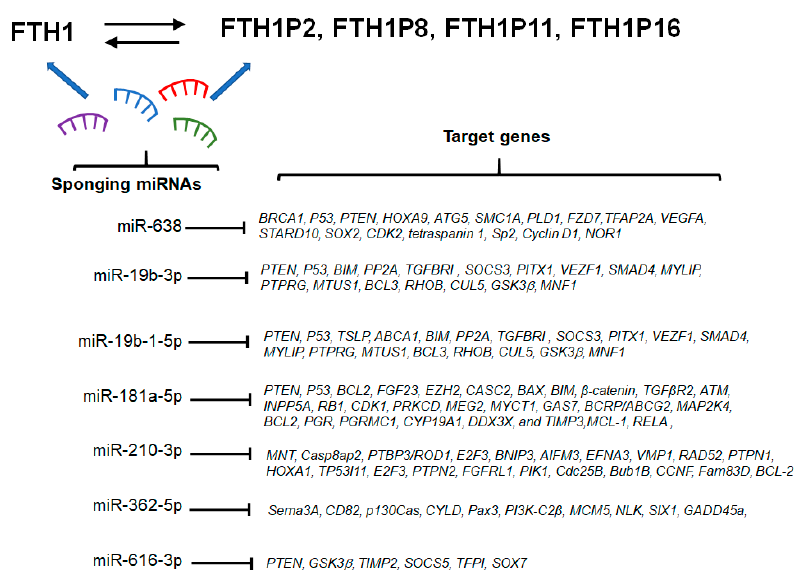
Figure 4. Potential networks involving FTH1 gene/pseudogenes and known oncogenes or tumor suppressor genes. Abbreviations used: BRCA1, BRCA1 DNA repair associated; P53, Tumor protein p53; PTEN, Phosphatase and tensin homolog; HOXA9, Homeobox A9; ATG5, Autophagy related 5; SMC1A, Structural maintenance of chromosomes 1A; PLD1, Phospholipase D1; FZD7, Frizzled class receptor 7; TFAP2A, Transcription factor AP-2 alpha; VEGFA, Vascular endothelial growth factor A; STARD10, StAR related lipid transfer domain containing 10; SOX2, SRY-box transcription factor 2; CDK2, Cyclin dependent kinase 2; TSPAN1, Tetraspanin 1; Sp2, Sp2 transcription factor; CCND1, Cyclin D1; NOR1, Neuron-derived orphan receptor 1; BIM, Bcl-2-like protein 11; PP2A, Protein phosphatase 2 phosphatase activator; TGFBR1, transforming growth factor beta receptor 1; SOCS3, Suppressor of cytokine signaling 3; PITX1, Paired like homeodomain 1; VEZF1, Vascular endothelial zinc finger 1; SMAD4, SMAD family member 4; MYLIP, Myosin regulatory light chain interacting protein; PTPRG, Protein tyrosine phosphatase receptor type G; MTUS1, Microtubule associated scaffold protein 1; BCL3, BCL3 transcription coactivator; RHOB, Ras homolog family member B; CUL5, Cullin 5; GSK3 β , Glycogen synthase kinase 3 beta; MNF1, Ubiquinol-cytochrome c reductase complex assembly factor 2; TSLP, Thymic stromal lymphopoietin; ABCA1, ATP binding cassette subfamily A member 1; BCL2, BCL2 apoptosis regulator; FGF23, Fibroblast growth factor 23; EZH2, Enhancer of zeste 2 polycomb repressive complex 2 subunit; CASC2, Cancer susceptibility 2; BAX, BCL2 associated X, apoptosis regulator; CTNNB1, β -catenin; TGF β R2, Transforming growth factor beta receptor 2; ATM, ATM serine/threonine kinase; INPP5A, Inositol polyphosphate-5-phosphatase A; RB1, RB transcriptional corepressor 1; CDK1, Cyclin dependent kinase 1; PRKCD, Protein kinase C delta; MEG2, Protein tyrosine phosphatase non-receptor type 9; MYCT1, MYC target 1; GAS7, growth arrest specific 7; BCRP/ABCG2, ATP binding cassette subfamily G member 2; MAP2K4, Mitogen-activated protein kinase kinase 4; PGR, Progesterone receptor; PGRMC1, Progesterone receptor membrane component 1; CYP19A1, Cytochrome P450 family 19 subfamily A member 1; DDX3X, DEAD-box helicase 3 X-linked; TIMP3, TIMP metallopeptidase inhibitor 3; MCL-1, MCL1 apoptosis regulator, BCL2 family member; RELA, RELA proto-oncogene NF-kB subunit; MNT, MAX network transcriptional repressor; Casp8ap2, Caspase 8 associated protein 2; PTBP3/ROD1, Polypyrimidine tract binding protein 3; E2F3, E2F transcription factor 3; BNIP3, BCL2 interacting protein 3; AIFM3, Apoptosis inducing factor mitochondria associated 3; EFNA3, Ephrin A3; VMP1, Vacuole membrane protein 1; RAD52, RAD52 homolog DNA repair protein; PTPN1, Protein tyrosine